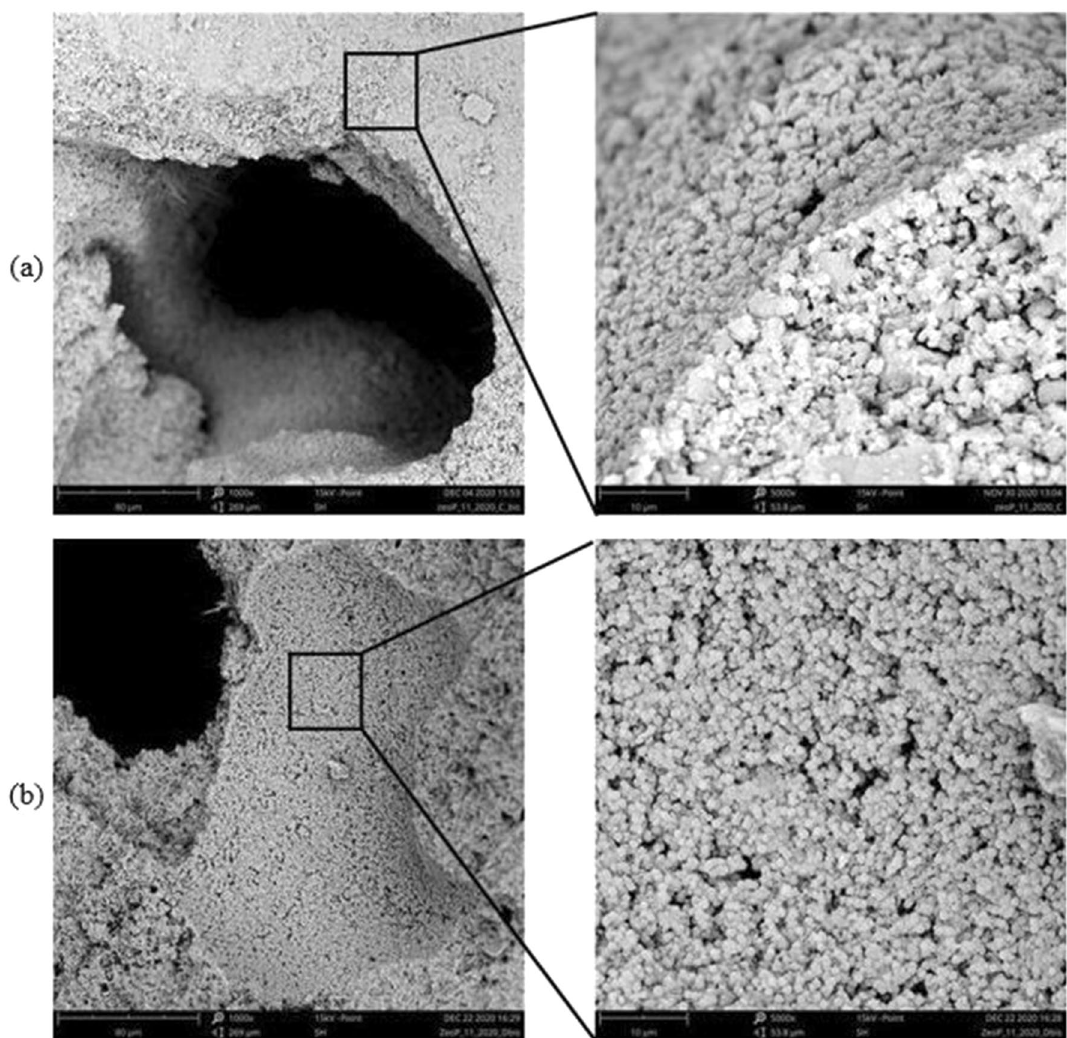
Figure 3. Microstructure of the sample after one day ( a ) and three days ( b ) of curing at different magnification (×1000 left and ×5000 right).